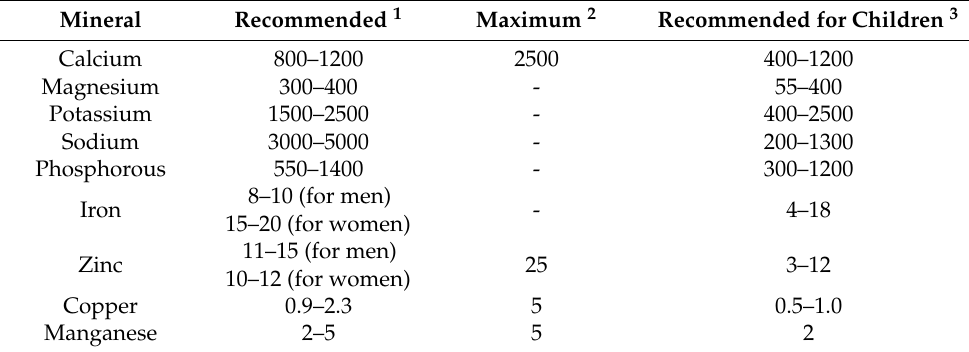
Table 6. Recommended daily allowance of minerals,